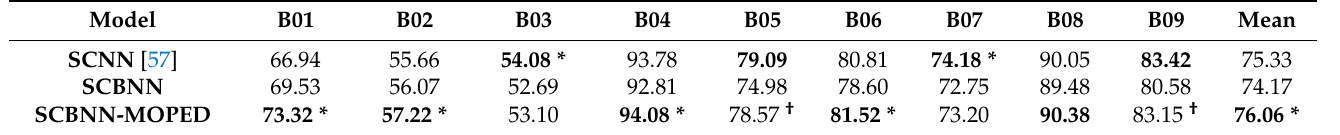
Table 5. Non-subject-specific classification results (% accuracy) on dataset